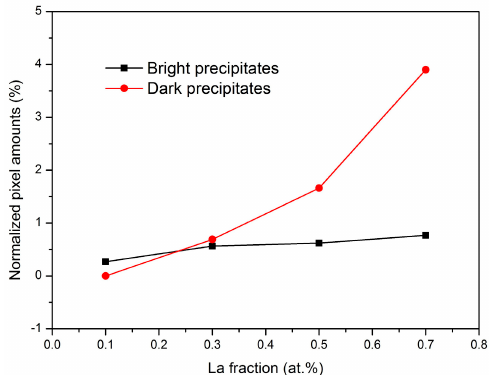
Figure 1. Back-scattering SEM images of Ni 50– x Ti 50 La x alloys: ( a ) Ni 49.9 Ti 50 La 0.1 ; ( b ) Ni 49.7 Ti 50 La 0.3 ; ( c ) Ni 49.5 Ti 50 La 0.5 ; ( d ) Ni 49.3 Ti 50 La 0.7 .